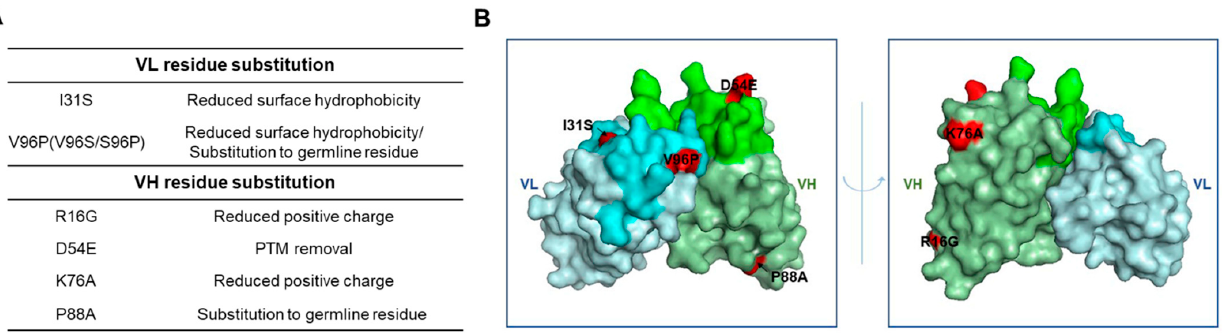
Figure 1. Schematic representation of the substitutions of Ab417 for improved biophysical properties. ( A ) Design of the VL and VH residue substitutions. ( B ) The 3D model of Ab417. The I31S and V96P in the VL and the R16G, D54E, K76A, and P88A in the VH are shown in red. Gray, VL; Green, VH; Lime , LCDR; Light green, HCDR.